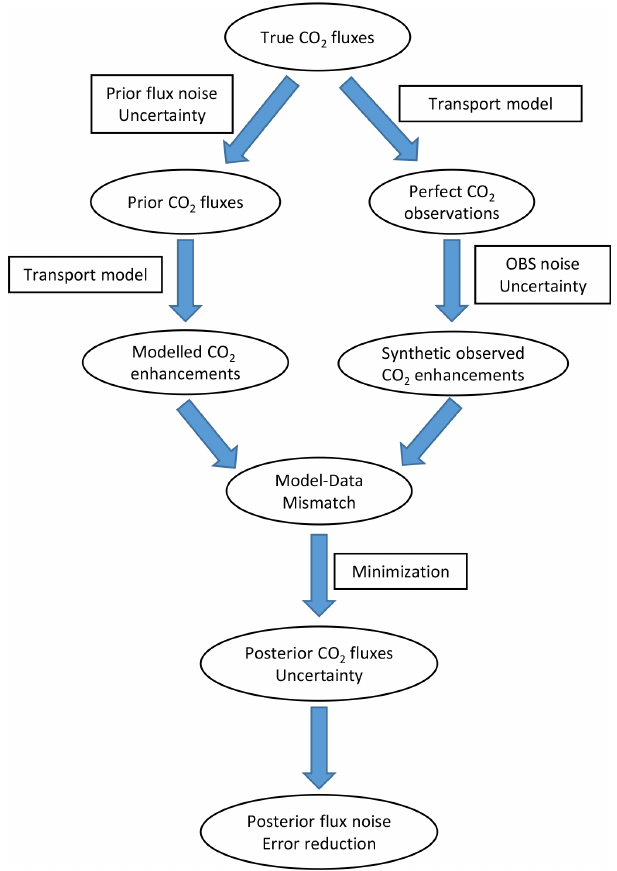
Figure 1. Flow chart of the Observing System Simulation Experi- ment (OSSE) for urban CO 2